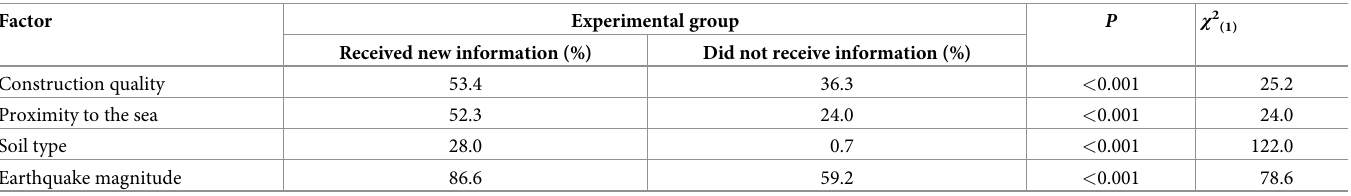
Table 4. Factors that determine the magnitude of an earthquake in a particular place and the damage it will cause (n =